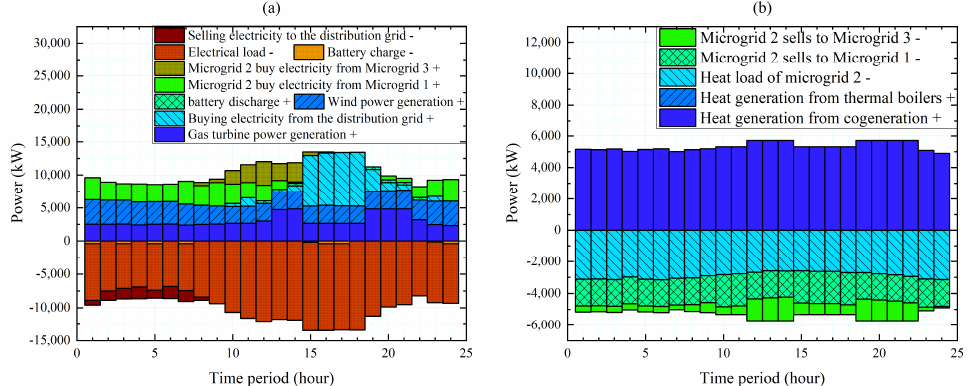
Figure 8. Post−alliance micro−grid 2 electric and heat balance results. ( a ) Electric balance results. ( b ) Figure 8. Post − alliance micro − grid 2 electric and heat balance results. ( a ) Electric balance results. Heat balance results. ( b ) Heat balance